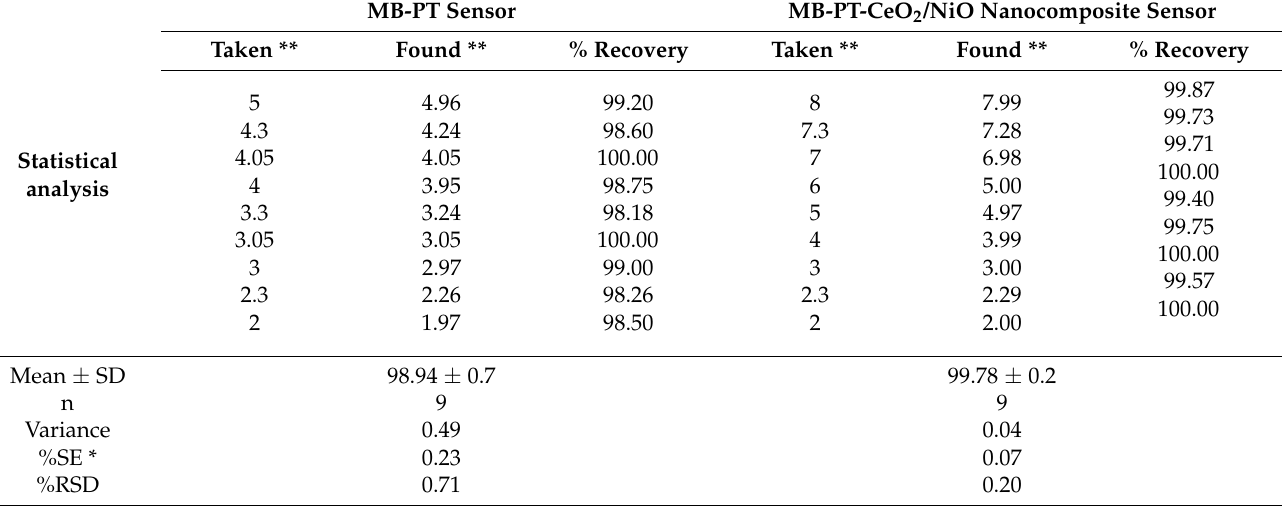
Table 4. Accuracy results from the determination of nine authentic samples of MB using MB-PT and MB-PT-CeO 2 /NiO nanocomposite.